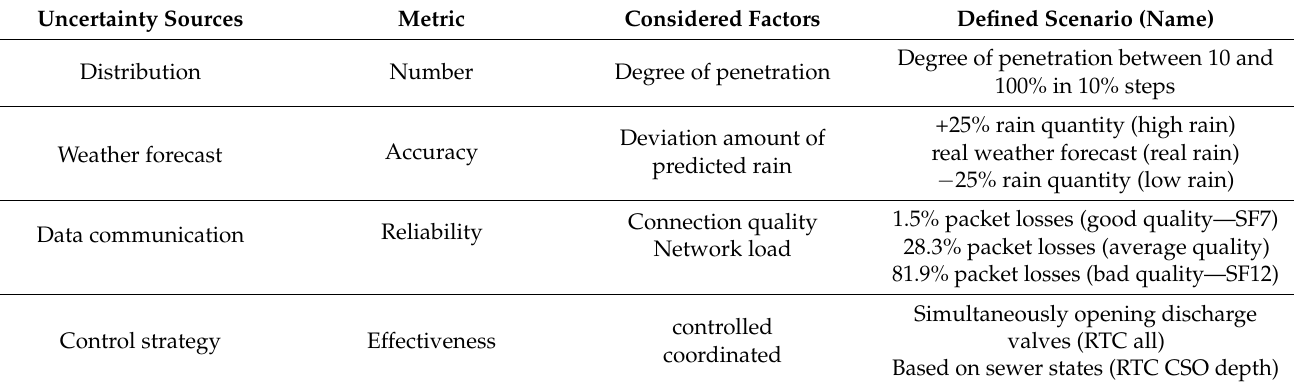
Table 2. Summary of considered scenarios and uncertainties for smart RWH